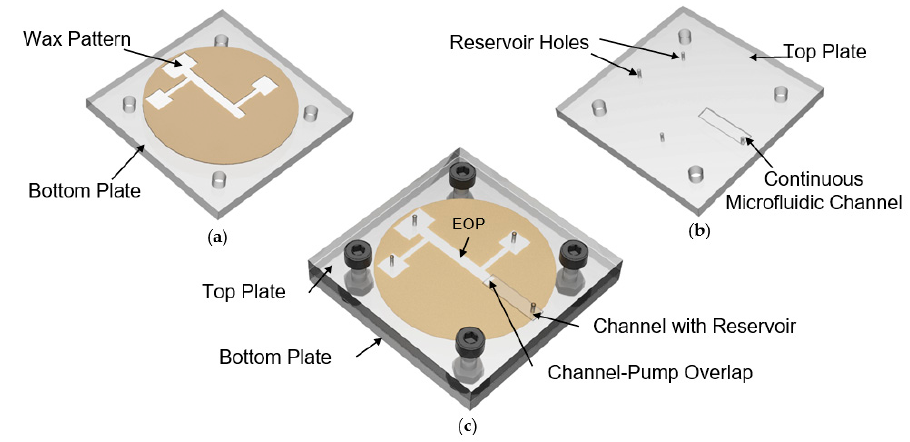
Figure 3. Fabrication of the system: ( a ) Wax pattern is extruded on paper. Paper is held on the bottom plate; ( b ) A continuous microfluidic channel and reservoir holes are made on top plate using a laser cutter; ( c ) Top plate is placed upside down on bottom plate and mechanically secured after wetting plate